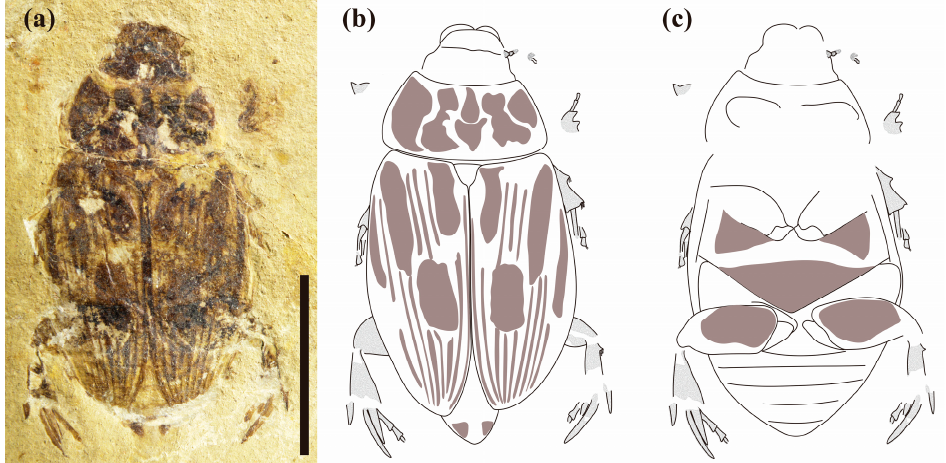
Figure 2. Photographs and line drawings of Antiqusolidus maculatus Lu, Ahrens, Bai, Shih & Ren gen. et sp.n. Paratype. ( a ) General habitus, scale 10 mm; ( b ) general habitus, dorsal view; ( c ) general habitus, ventral view.